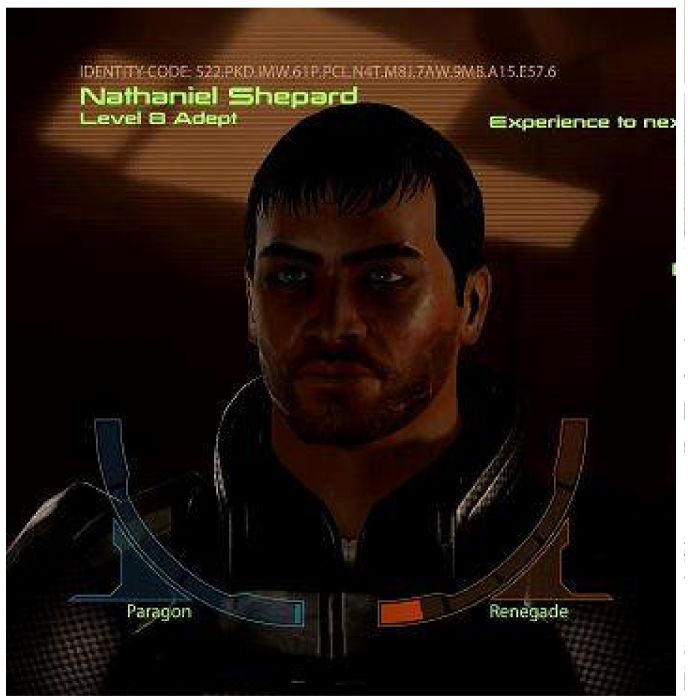
Figure 4. Character view with Paragon/Renegade